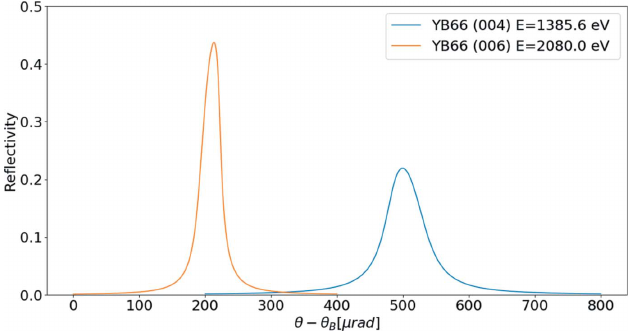
Figure 6 Diffraction profiles for YB 66 004 at 1385.8 eV and YB 66 006 at 2080 eV using the anisotropic temperature factor. Peak values are 0.22 and 0.44; FWHM values are 64.1 m m and 32.0 m m, respectively.